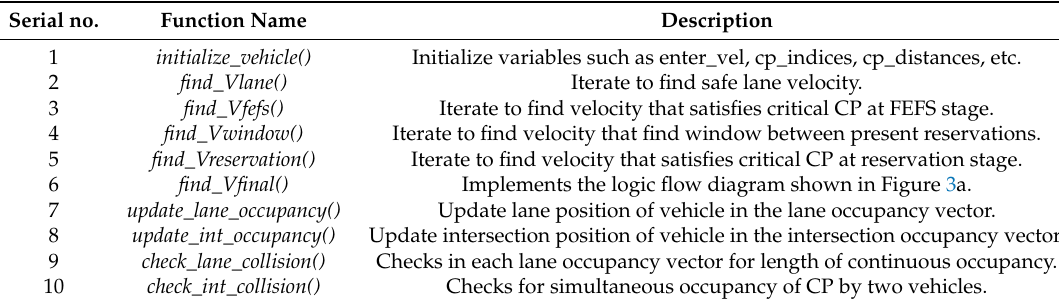
Table 2. Functions used in Uppaal